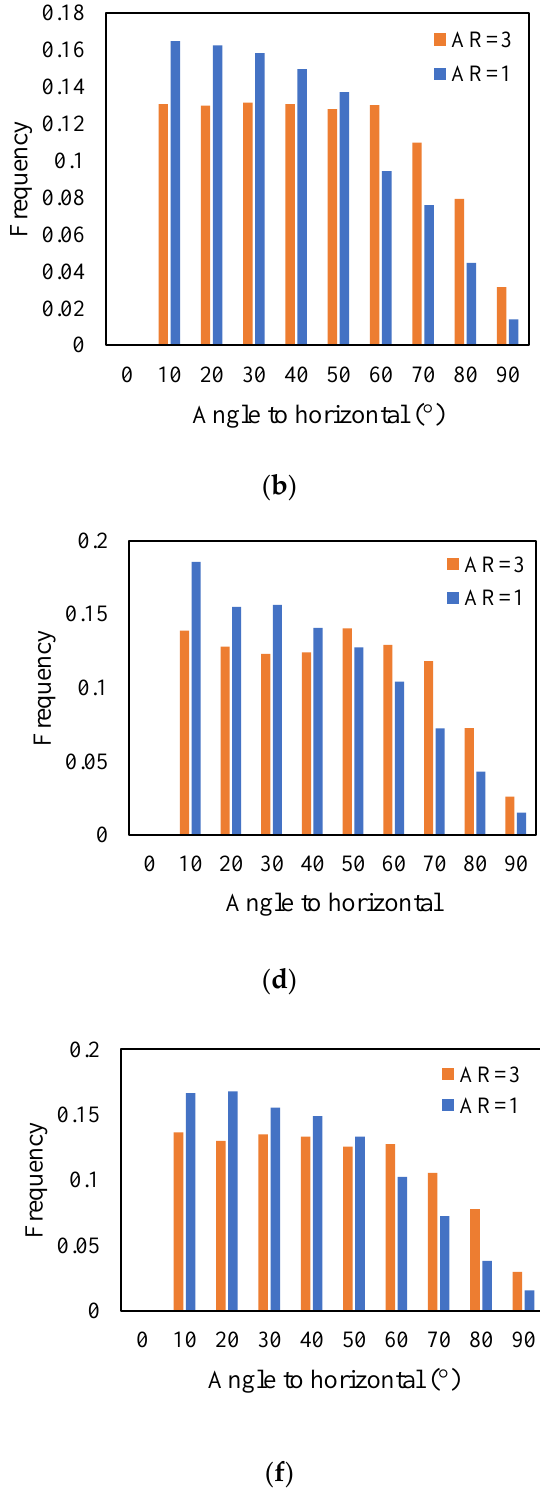
Figure 5. Histogram of vertical orientation of cylinders in final packings of binary mixtures: ( a ) AR = 1 (25%) and AR = 2 (75%), ( b ) AR = 1 (25%) and AR = 3 (75%), ( c ) AR = 1 (50%) and AR = 2 (50%), ( d ) AR = 1 (50%) and AR = 3 (50%), ( e ) AR = 1 (75%) and AR = 2 (25%) and ( f ) AR = 1 (75%) and AR = 3 (25%).